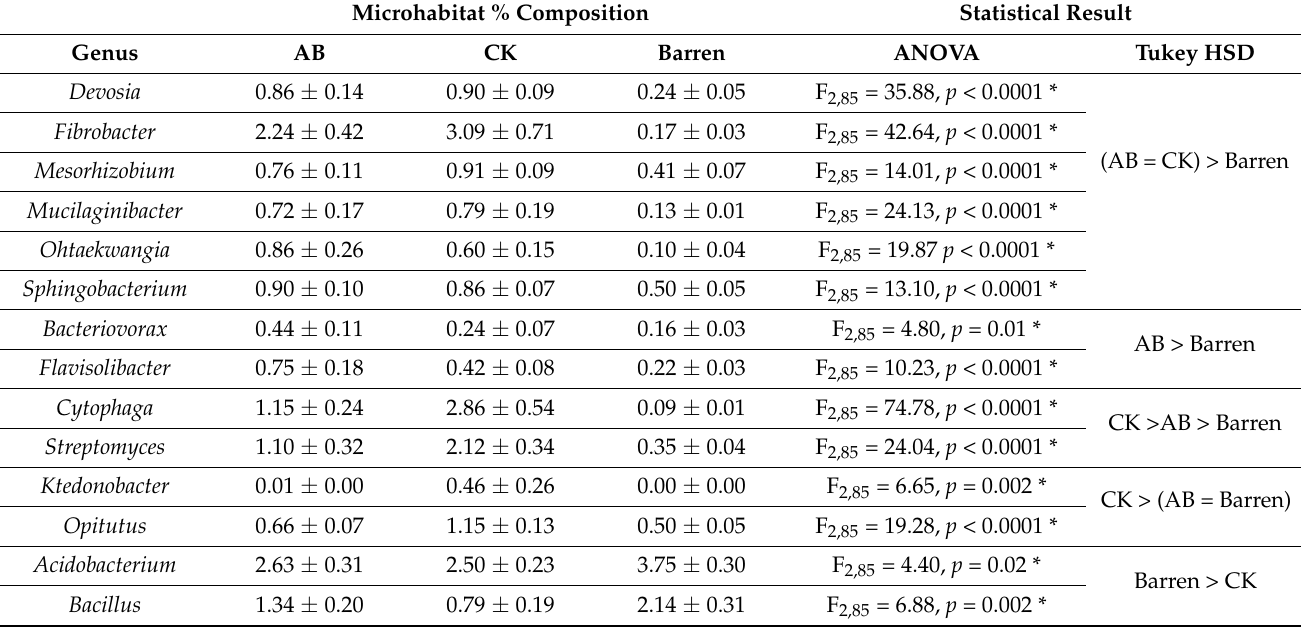
Table 2. Percent composition of the topmost prevalent genera varied across the two plant species, native A. breviligulata (AB) and invasive C. kobomugi (CK) and the microhabitats lacking vegetation (Barren). Means are ± standard error. Asterisk (*) indicate P -values below